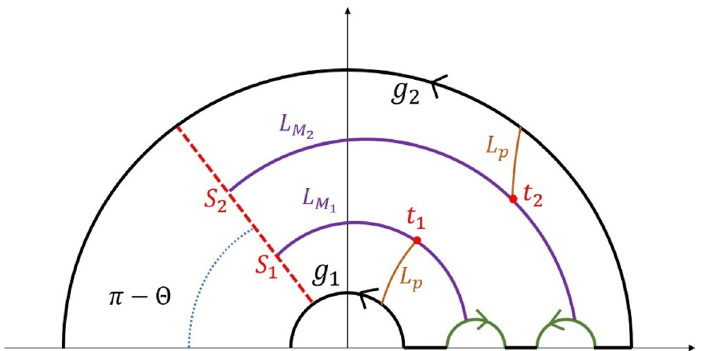
Figure 28 . L M in figure 13 is depicted as two purple arcs in the covering space. The geodesic L p 1 is represented by the brown curves with two intersection points on L M